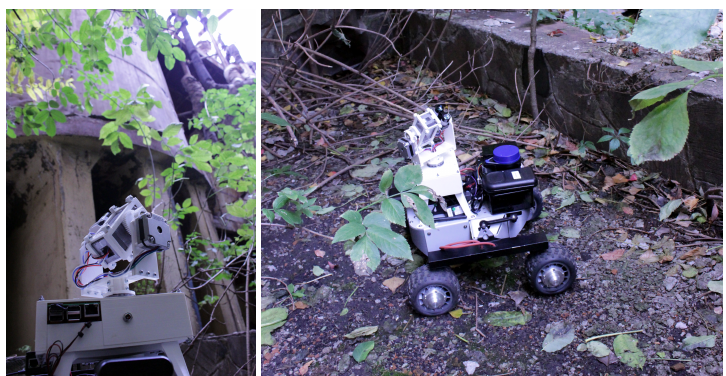
Figure 10. Mobile deployment of CC-RIAS in outdoor environments on the PChP nuclear site in Kamianska, Ukraine. CC-RIAS was deployed to scan waste water tanks to determine radiologi- cal